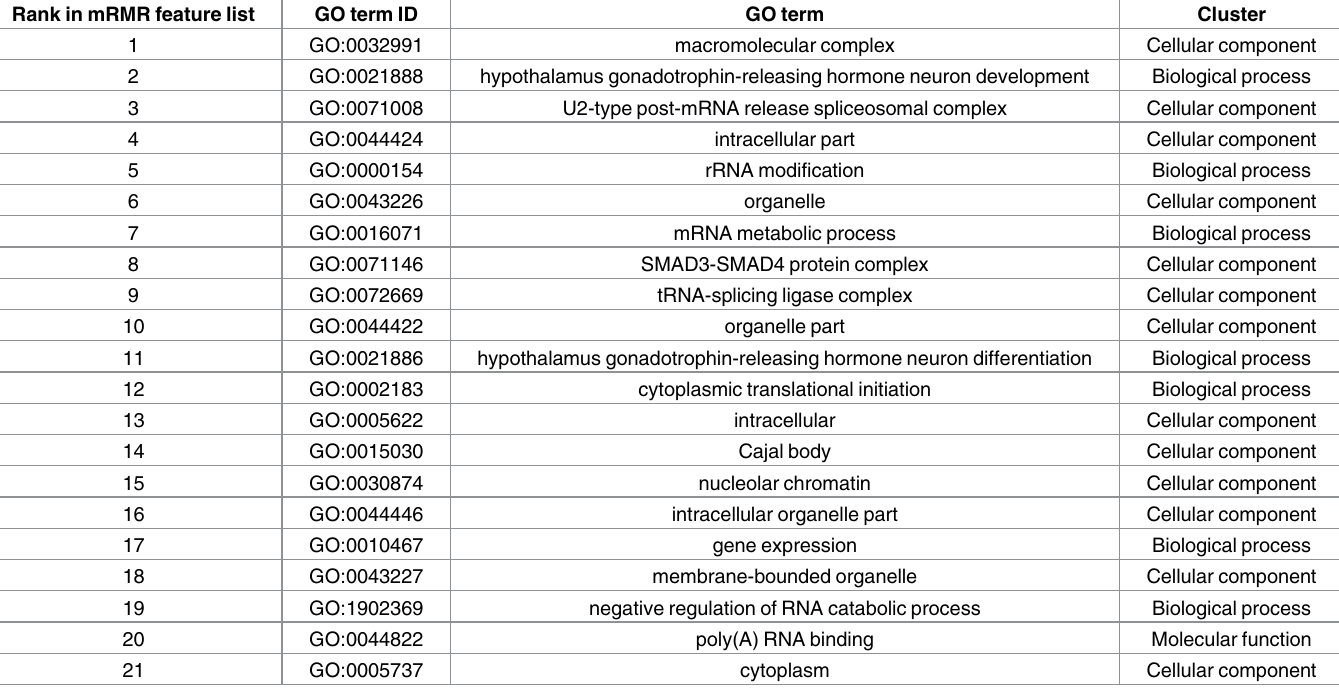
Table 2. Twenty-one GO terms corresponding to the top 21 features in the mRMR feature